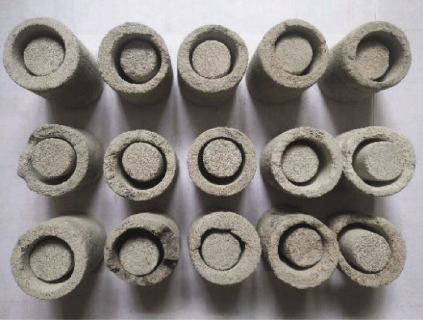
Figure 3: Images of the core